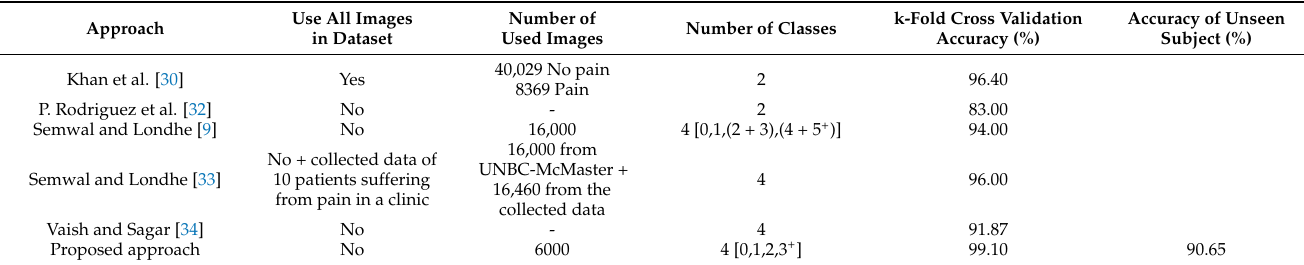
Table 5. Comparison with other approaches using UNBC-McMaster dataset.